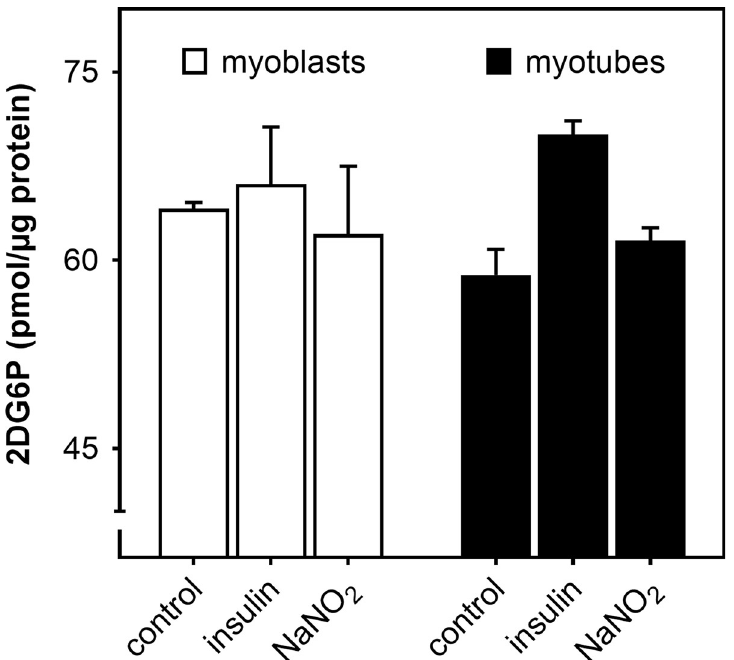
Fig 8. Nitrite does not affect glucose uptake by skeletal muscle cells. Static myoblasts (open bars) and spontaneously contracting myotubes (filled bars) were grown and assayed under the same conditions as those applied during extracellular flux analysis, and were exposed to 1 μ M NaNO 2 for 30 min with and without 100 nM human insulin. Glucose uptake was assayed as 2-deoxyglucose-6-phosphate (2DG6P) accumulated over a 30-min period. Data are means ± SEM of 3 independent experiments with each condition assayed in triplicate. Differences between differentiation state and assay conditions were evaluated by 2-way ANOVA and were found not significant.